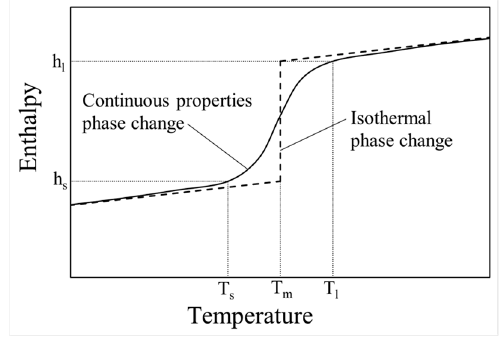
Figure 2. Enthalpy versus temperature for isothermal and continuous properties phase change.